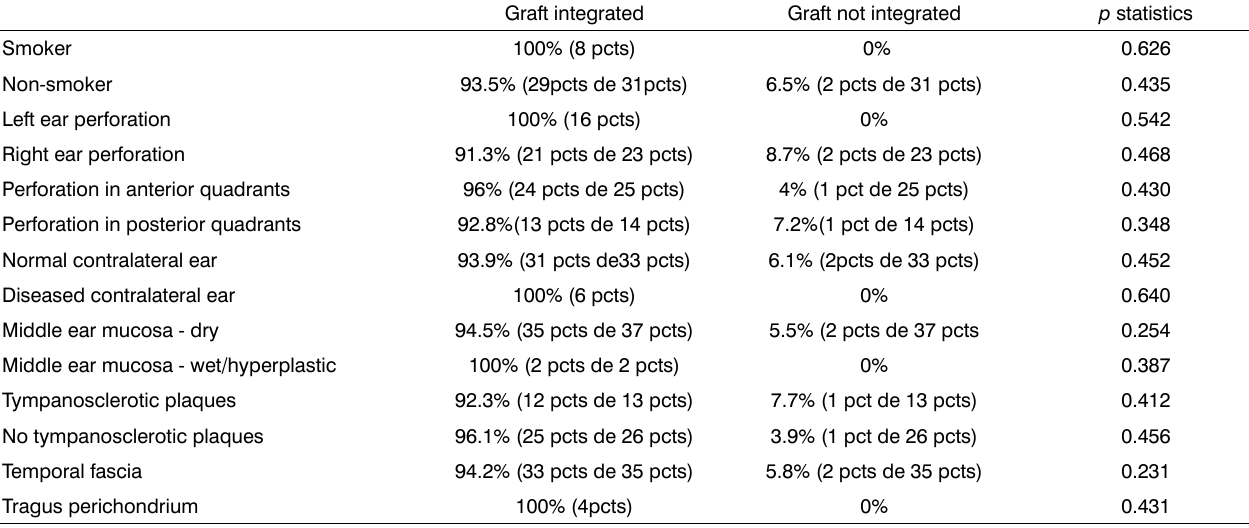
Table 2. Graft integration or not relatie to several parameters (total